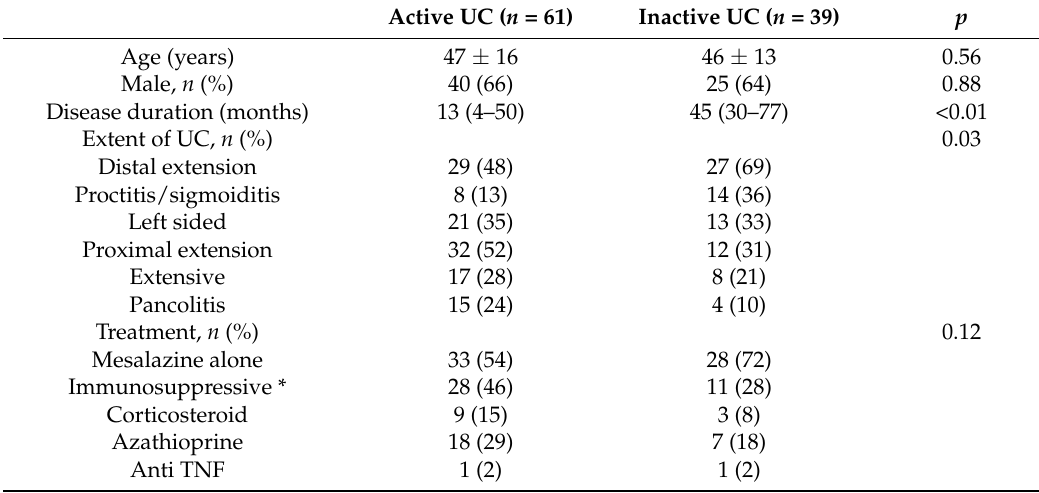
Table 1. Clinical and demographical characteristics of active and inactive patients with ulcerative colitis (UC).